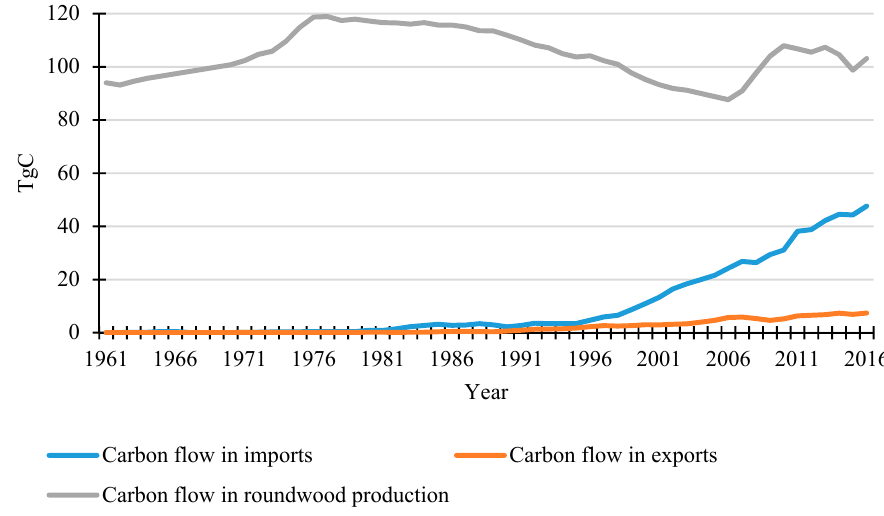
Figure 4. Carbon flow in domestic roundwood production, imports and exports in China.